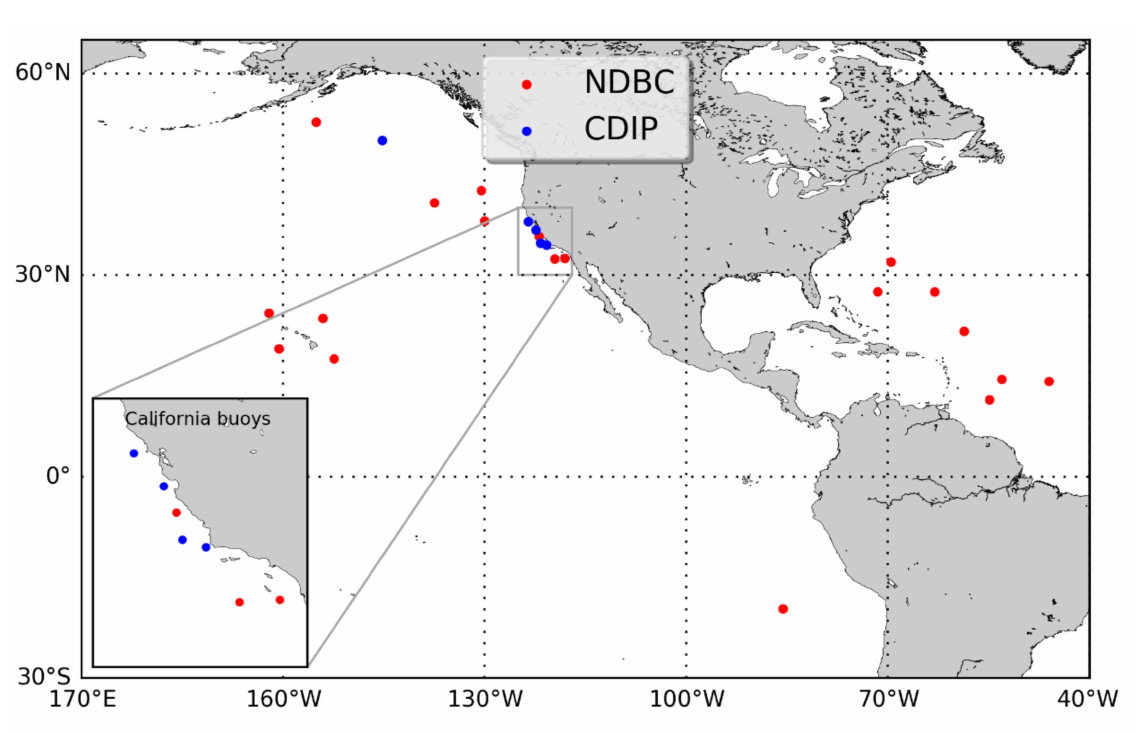
Figure 6. Location of directional wave buoys from the NDBC and CDIP